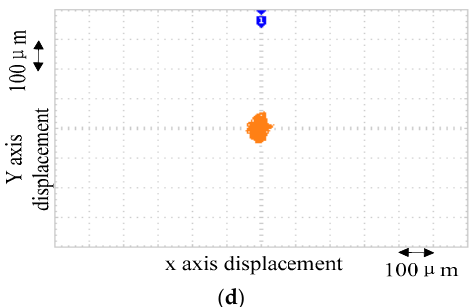
Figure 9. Experimental results of system dynamic response: ( a ) the diagram of speed mutation controlled by Proportional ‐ Integral (PI); ( b ) the diagram of speed mutation controlled by SMC; ( c ) the diagram of speed mutation controlled by ASMC; ( d ) the diagram of rotor radial displacement controlled by ASMC.